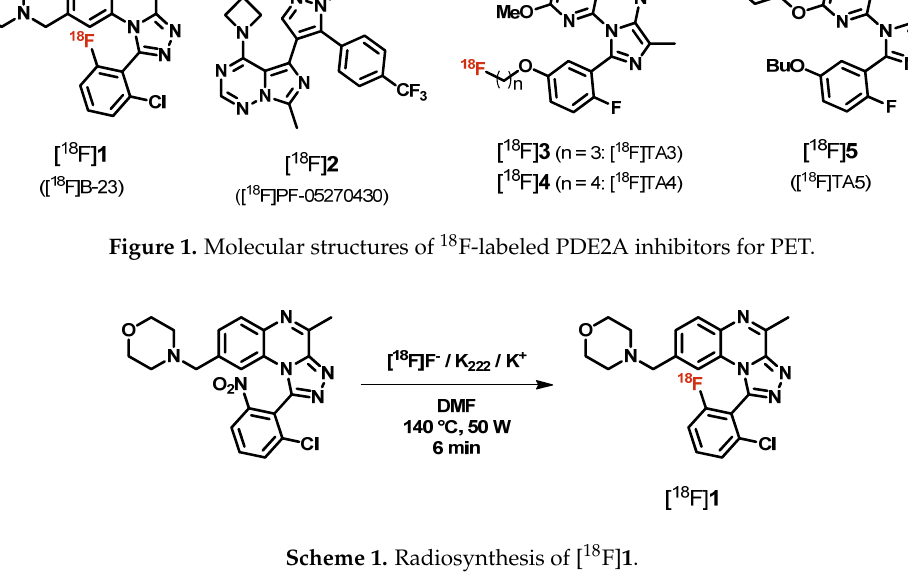
Scheme 1. Radiosynthesis of [ 18 F] 1 Scheme 1. Scheme 1.